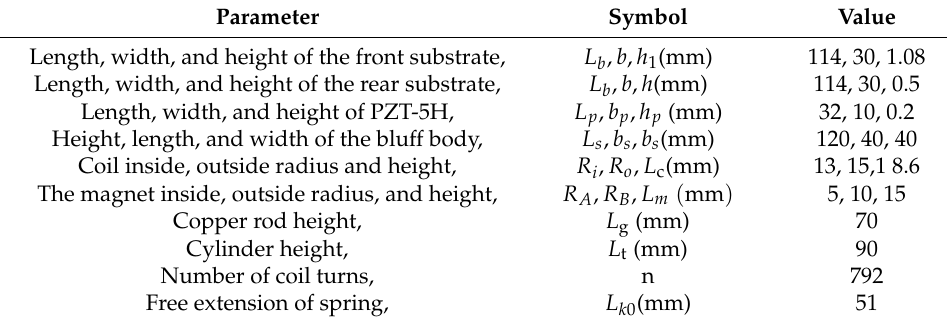
Table 1. Structure parameters.